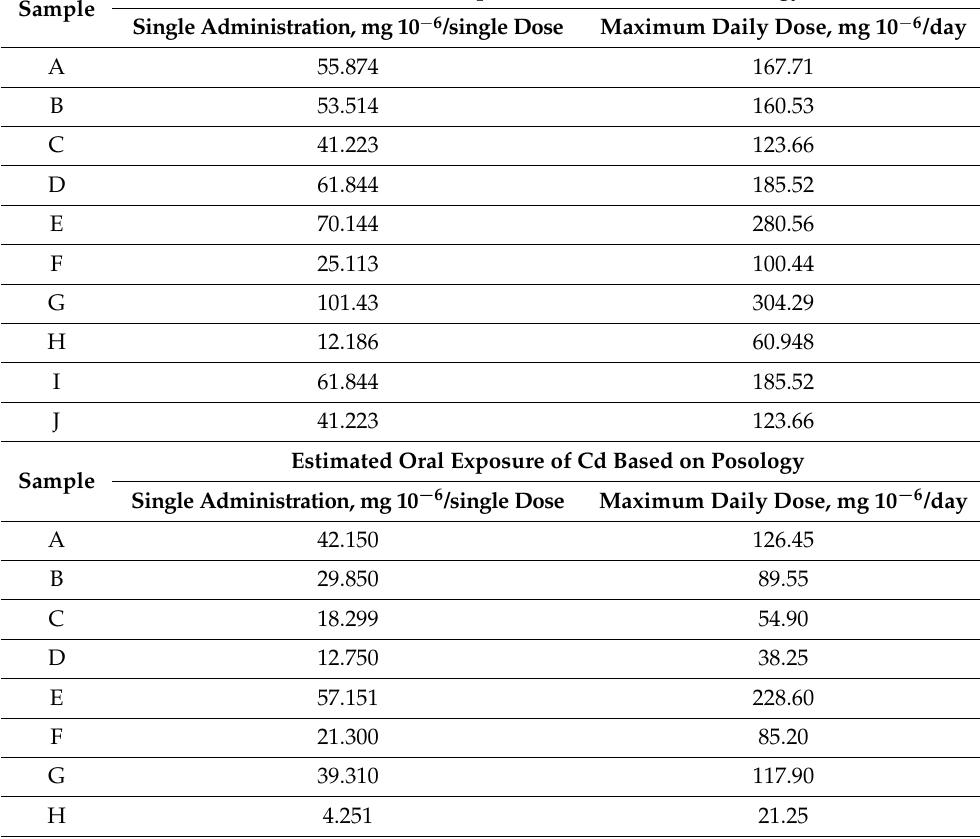
Table 5. The calculated exposure of Pb and Cd in single administration and maximal daily dose for each THMP with A. officinalis L., radix (marshmallow root) available in Polish pharmacies.